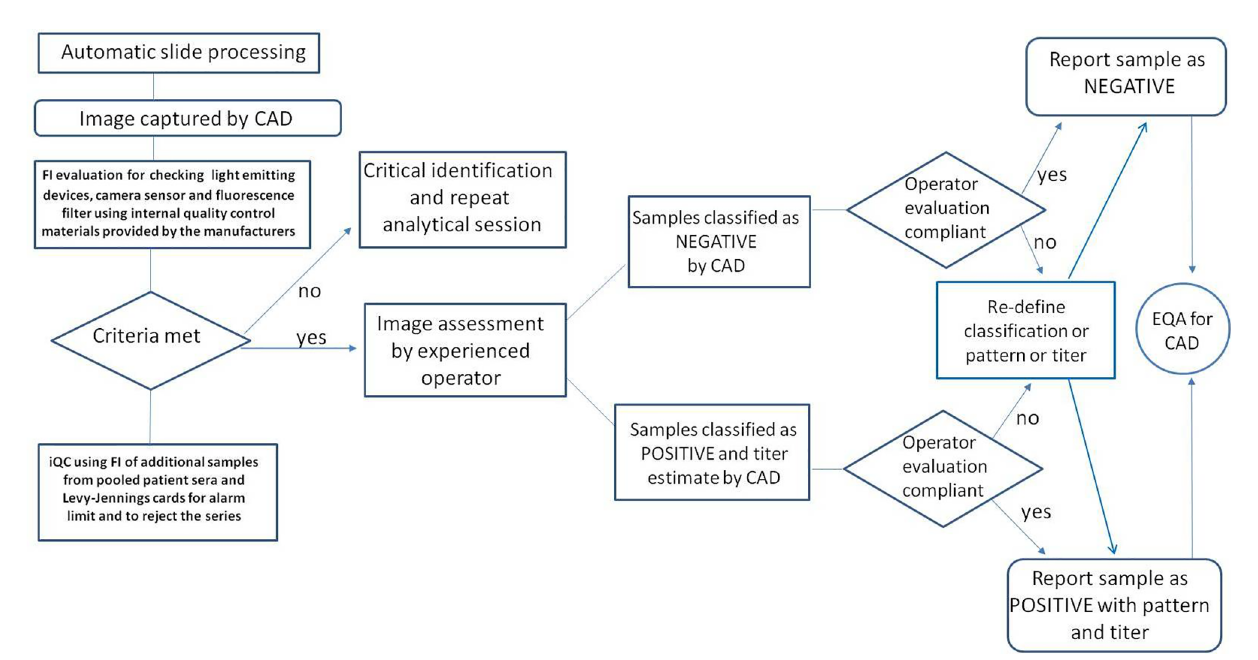
FIGURE 2 | Steps related to quality control and interpretation of the results using the automated CAD procedure for the determination of ANA in indirect immuno fl